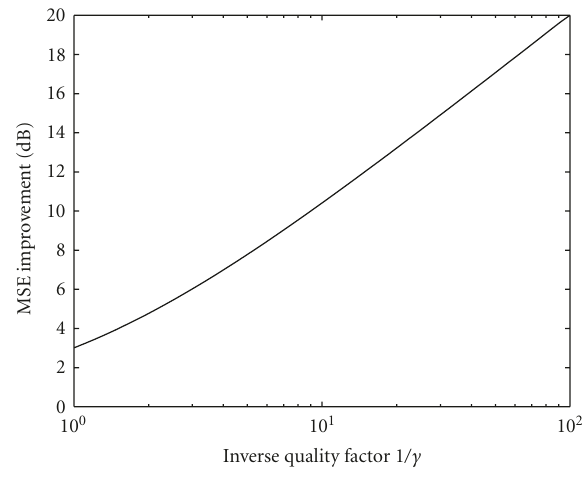
Figure 2: MSE improvement as function of quality factor for opti- mized power